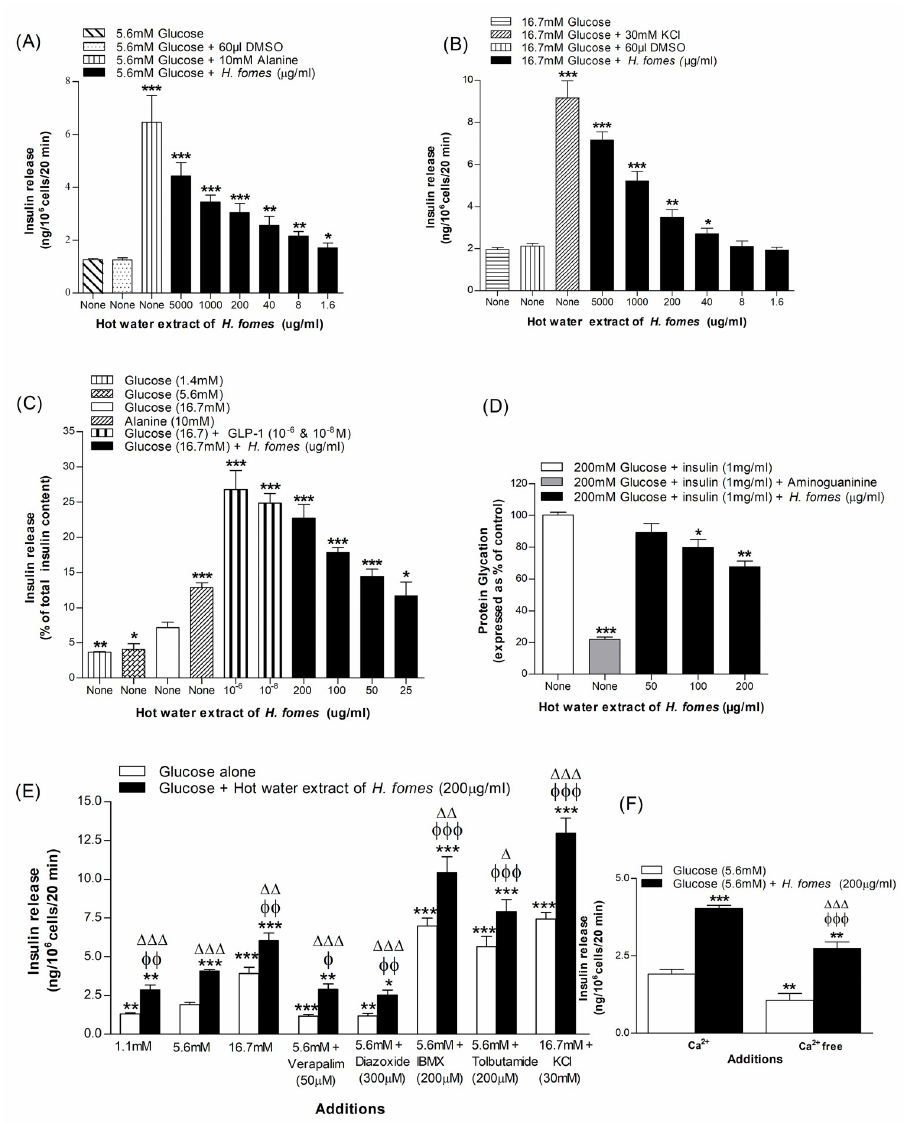
Fig 1. Effects of HWHF on insulin secretion from (A & B) BRIN-BD11 cells and (C) pancreatic islets, (D) protein glycation, (E) insulin release in the presence of established stimulators or inhibitors and (F) absence of extracellular calcium. Values are Mean ± SEM for n = 4–8 for insulin secretion and n = 3 for protein glycation. � p < 0.05, �� p < 0.01 and ��� p < 0.001 compared to control (5.6/16.7 mM glucose and 220 mM glucose + insulin (1 mg/ ml)). ϕ p < 0.05, ϕϕ p < 0.01 and ϕϕϕ p < 0.001 compared to 5.6 mM glucose in the presence of HWHF. Δ p < 0.05, ΔΔ p < 0.01 and ΔΔΔ p < 0.001 compared to incubations without